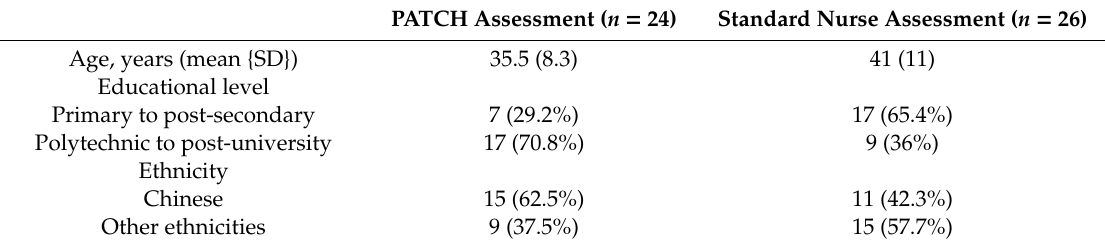
Table 1. Demographic characteristics at study entry ( n = 50).